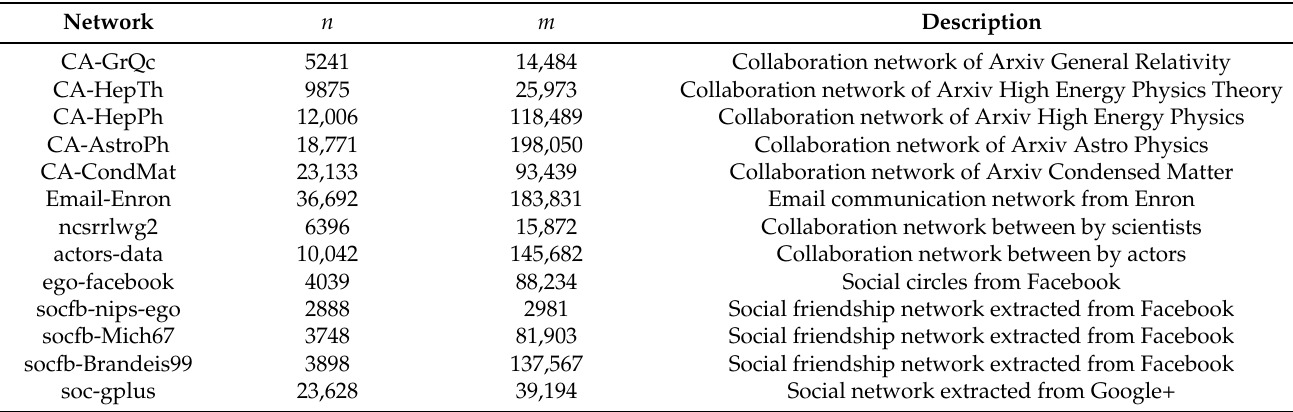
Table 3. Large-scale real social networks used in